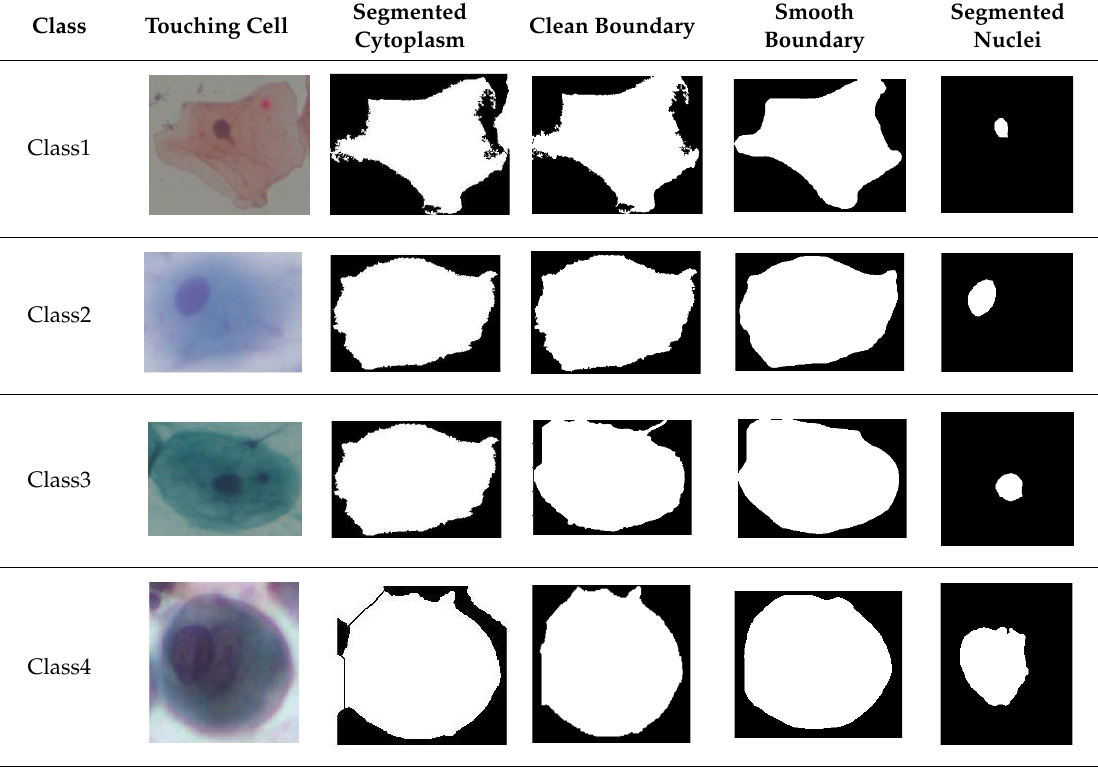
Table 8. Nuclei and Cytoplasm Segmentation for touching cells.